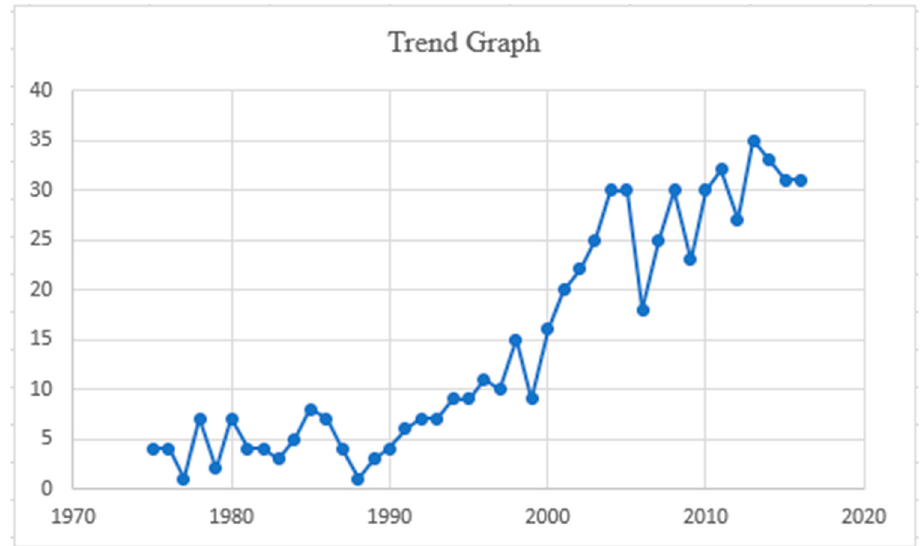
Figure 1. Trend analysis graph from 1975 to 2016. Table 2. Tumor characteristics and metastasis of 609 patients with parathyroid cancer from the Surveillance, Epidemiology, and End Results (SEER) database,